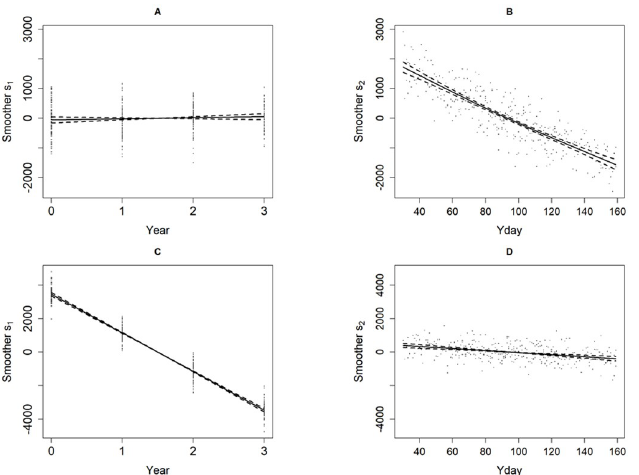
Fig 6. Smoothers (solid line); s 1 for year and s 1 for day within the year (Yday), with 95% confidence bands (dashed) and partial residuals (dots) obtained by fitting the GAM model to the paired data of (A-B) Scenario 1 and bottom row (C-D) Scenario 2. For Scenario 1, the plots respectively indicate in (A) no long-term trend (p = 0.282), in (B) a seasonal decline which is highly statistically significant (p = 2e-16). Conversely, for Scenario 2, in (C) the long-term decline trend is highly statistically significant (p = 2e-16), in (D) the seasonal linear downward trend is highly statistically significant (p = 4.05e-09). The fitted GAM model diagnostics were reasonable for both Scenarios (see Supporting Information S3 Figures (1–2) in S1